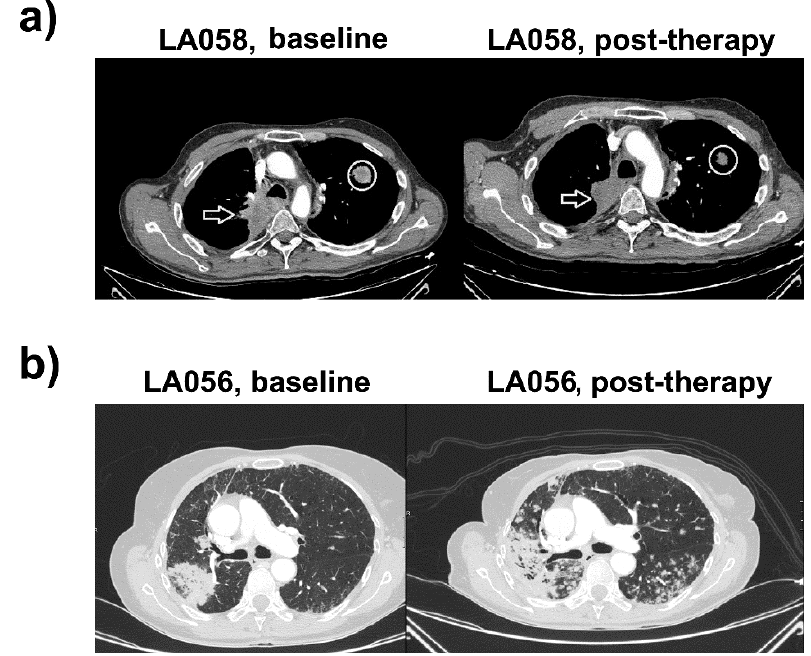
Figure 1. Clinical responses for tumor PD-L1-negative patients LA058 and LA056 treated with atezolizumab. ( a ) Left, CT images of LA058 before the start of immunotherapy. Right, CT images of LA058 after atezolizumab, demonstrating objective clinical responses, with evident tumor shrinkage. Arrows indicate a paravertebral upper right lobe mass with mediastinal invasion and posterolateral wall of the trachea. The circle indicates a contralateral metastatic node in the upper left lobe. Both lesions show a marked morphological decrease compatible with a partial response. ( b ) Left, CT evaluation of the LA056 patient. A tumoral relapse in the site of previous surgical intervention is evident. Right, CT following atezolizumab treatment. Tumor progression with bilateral pulmonary nodes and increase of the lower right lobe (LRL) mass, consistent with fast progressive disease.